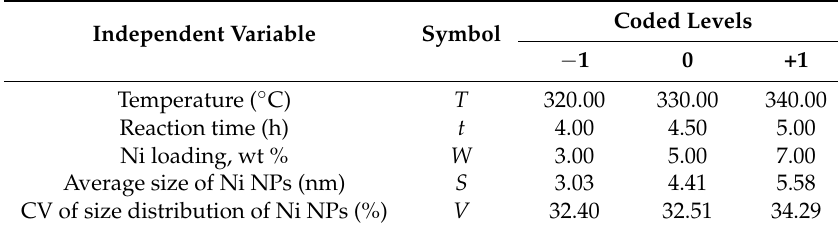
Table 7. Value range and coded levels of the independent